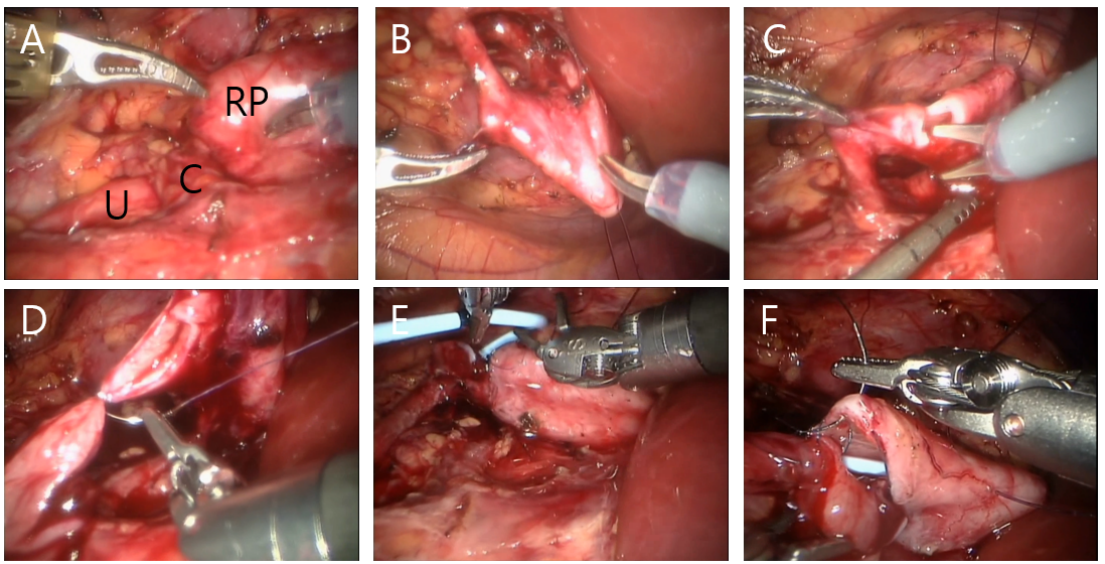
Figure 3. Surgical procedure of right RALP with crossing vessel. Renal pelvis (‘RP’), ureter (‘U’) and crossing vessel (‘C’) were observed ( A ). An anchoring stitch of renal pelvis is being made using 2-0 nylon suture ( B ). Dissection of renal pelvis and longitudinal ureter incision using scissors ( C ). Ureter anastomosis between renal pelvis and ureter was performed using 5-0 polyglyconate and 5-0 or polygalactin suture ( D ). Antegrade DJ stent was indwelled ( E ). Anterior wall anastomosis ( F ).